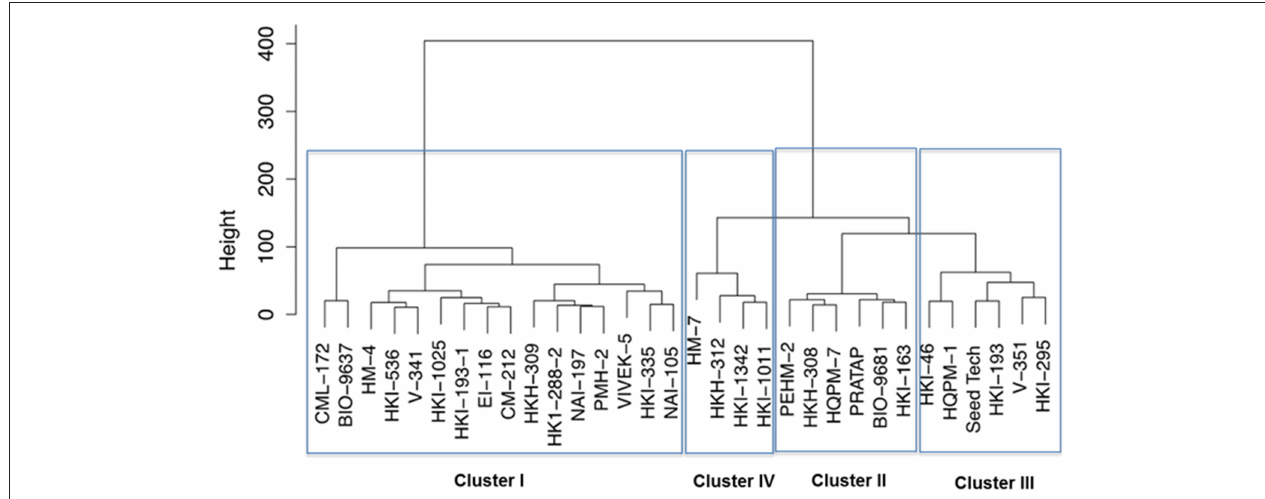
FIGURE 2 | Dendrogram of maize genotypes classified by Ward’s method of hierarchical clustering of the squared Euclidean distance matrix of 15 traits grown under low (50 µ M) nitrogen.